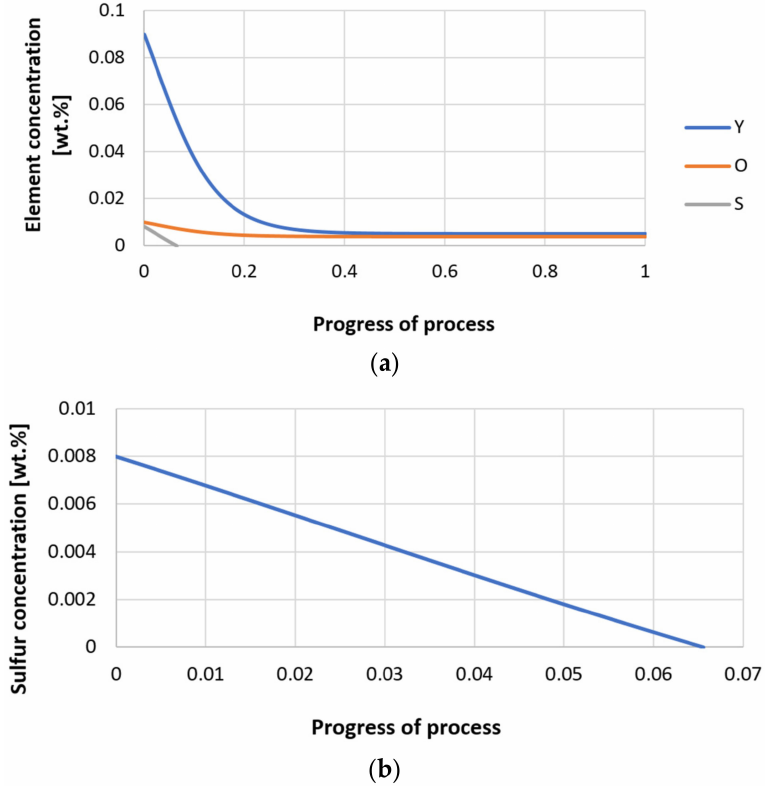
Figure 31. ( a , b ) Change of component concentration during the growth of a bi-component nucleus (Y 2 O 3 –Y 2 S 3 ) in steel 3 (for r 0 = 5 µ